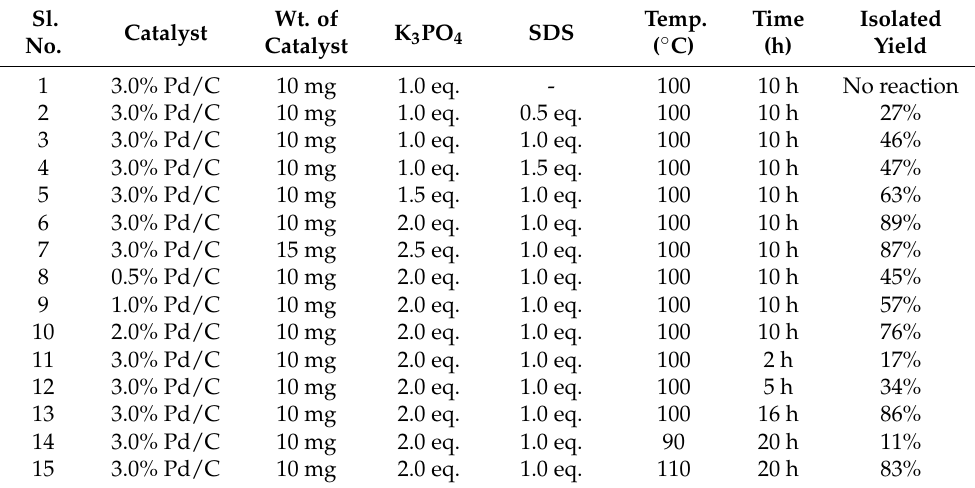
Table 1. Mizoroki–Heck reaction optimization of the Pd/C